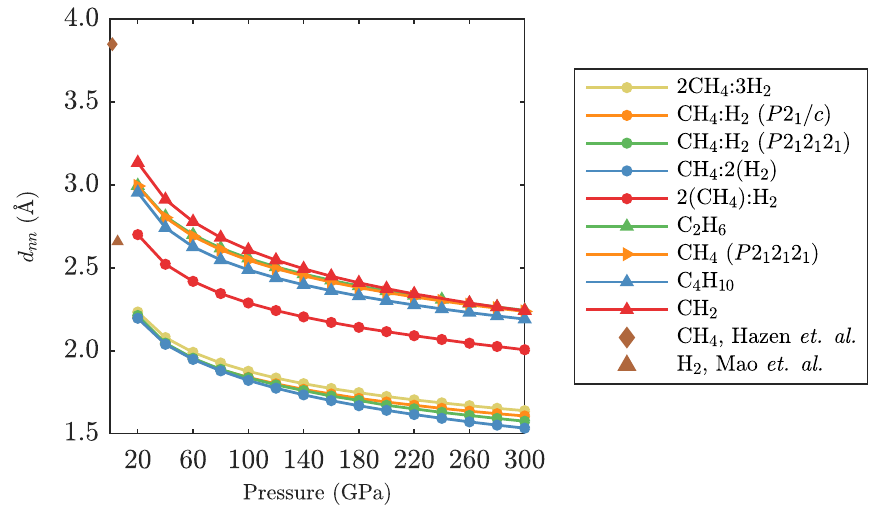
Figure A2. Calculated nearest neighbour distances d nn as function of pressure, for all molecular crystals studied in this work. Experimental data points for hydrogen phase I from Mao et al. [68] and for methane I from Hazen et al. [25].